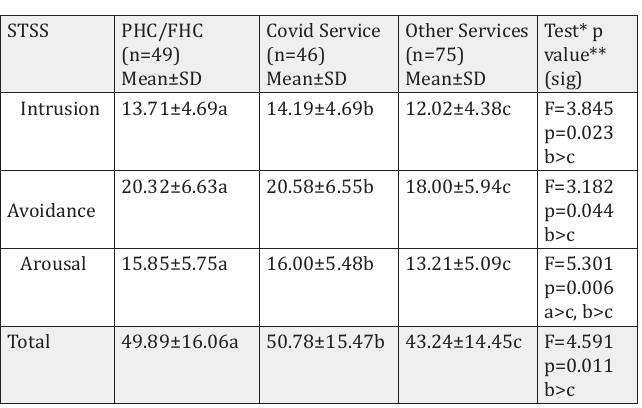
Comparison of Average Scores that Midwives Obtain from Secondary Traumatic Stress Scale (STSS) Total and Subdimensions in terms of the Unit They Work At